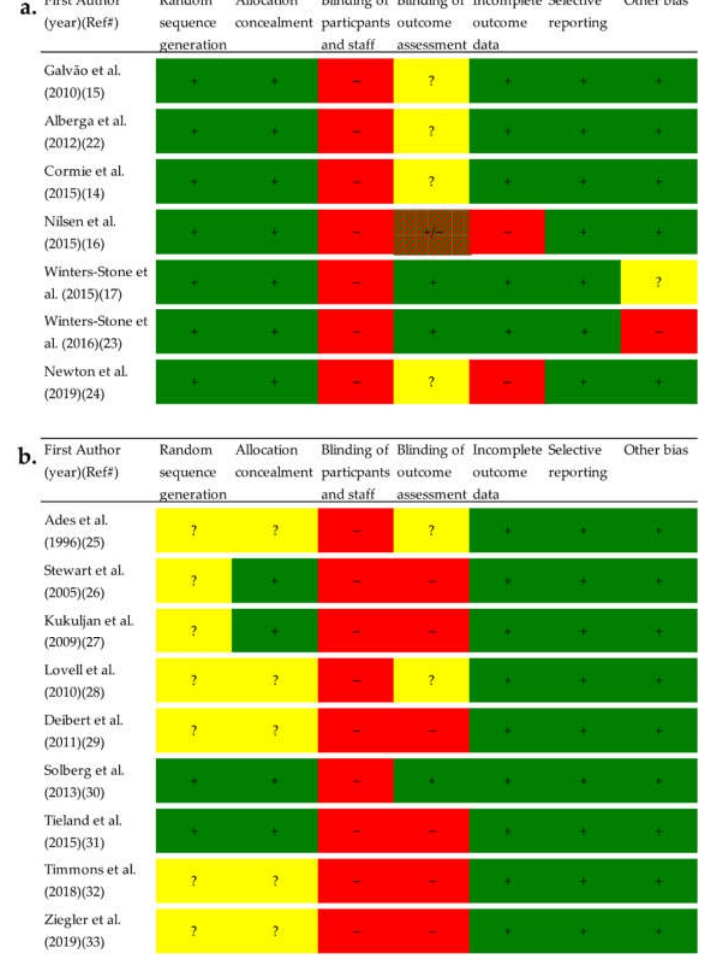
Figure 2. Risk of bias assessment for ( a. ) Prostate cancer patients and ( b. ) Healthy elderly men. Each risk of bias item in the included studies were evaluated as meeting the criteria for low risk of bias with “yes” (+), “no” (−), or “unclear” (?). Abbreviation: Ref#, Reference